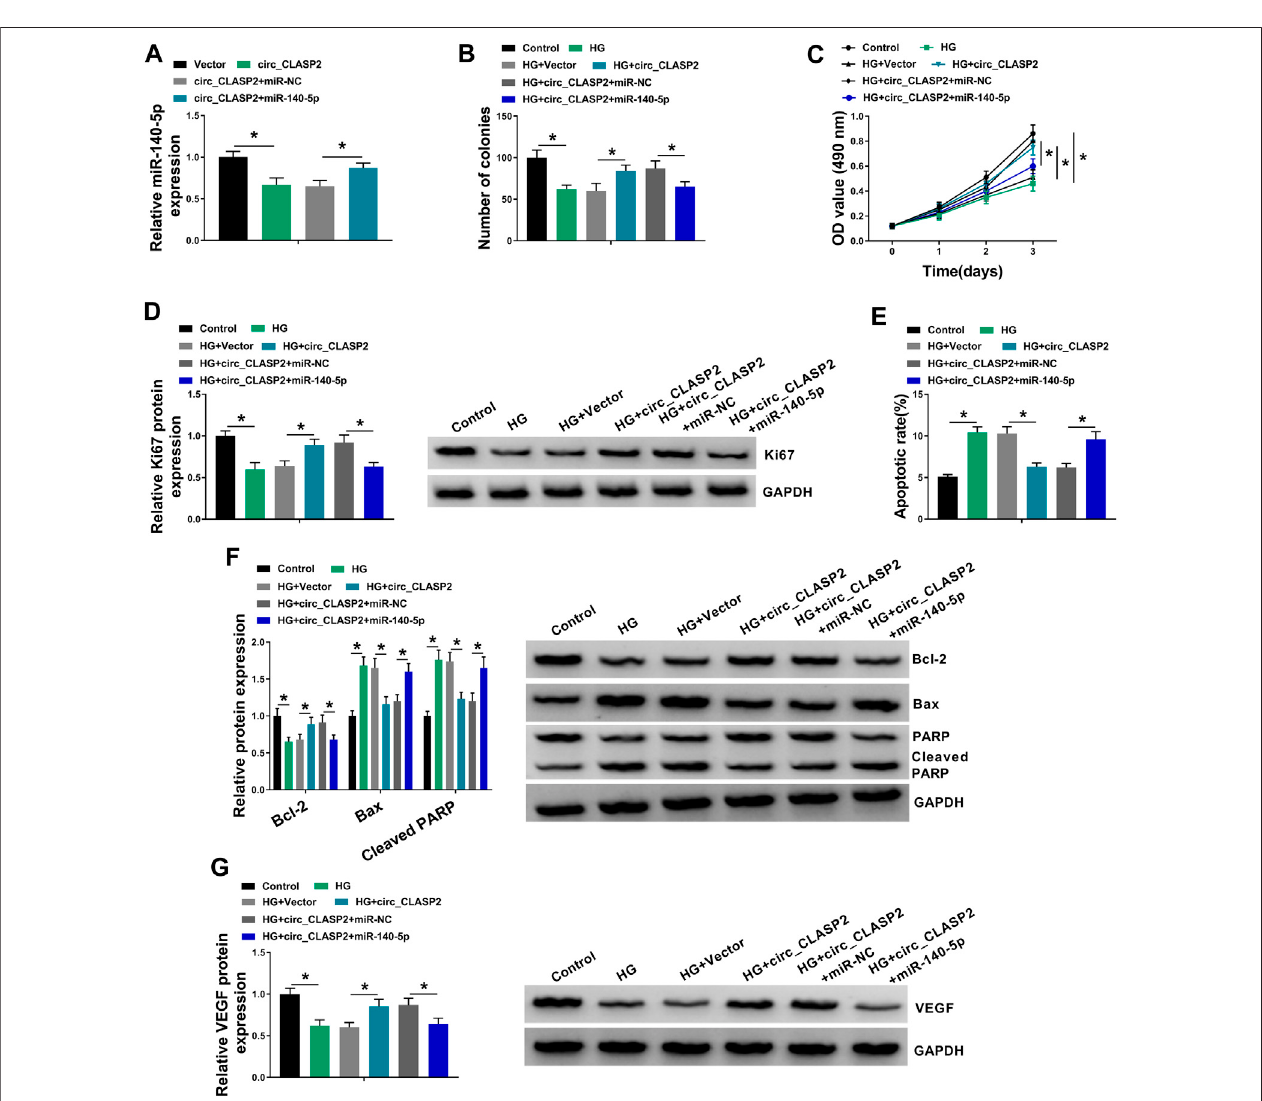
FIGURE4| Overexpressionofcirc_CLASP2 regulatedproliferationandapoptosisofHG-treatedHUVECsbymiR-140-5p. (A) MiR-140-5pexpression wastested by qRT-PCR in HUVECs transfected with Vector, circ_CLASP2, circ_CLASP2+miR-NC mimic, or circ_CLASP2+miR-140-5p mimic. HUVECs were transfected with Vector, circ_CLASP2, circ_CLASP2+miR-NC mimic, or circ_CLASP2+miR-140-5p mimic before HG treatment, followed by the determination of cell colony formation using a colonyformationassay (B) ,cell proliferationbyMTT assay (C) ,Ki67 level byWesternblot (D) , cellapoptosis by fl owcytometry (E) , Bcl-2, Baxand Cleaved PARP levels (F) , and VEGF expression (G) by Western blot. Vector: negative control vector, circ_CLASP2: circ_CLASP2 overexpression vector. n (cid:2) 3 independent biological replicates; data were presented as mean ± SD; * p < 0.05 by ANOVA followed by Tukey – Kramer post hoc test.